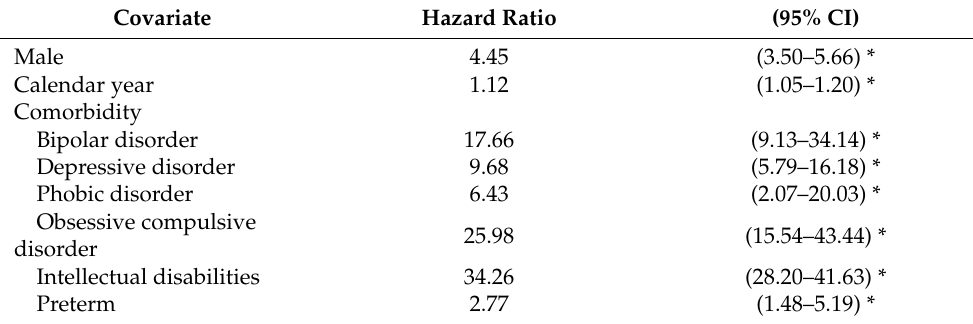
Table 2. The hazard ratio and its 95% confidence interval (95%CI) associated with each covariate for autism spectrum